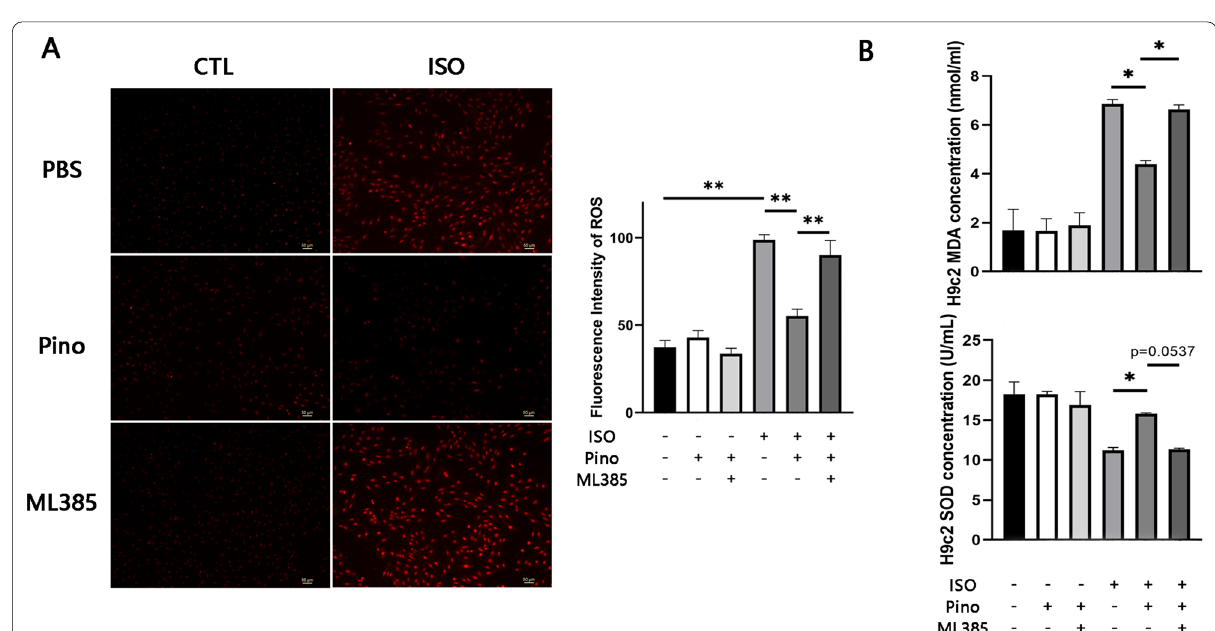
Fig. 5 In vitro incubation of Nrf2 inhibitor 5 μM ML385 counteract the antioxidant effects of pinocembrin. A , B ROS scavenging and antioxidant defense of pinocembrin were significantly offset by the application of ML385. *p < 0.05; **p < 0.01. ROS reactive oxygen species, Nrf2 nuclear factor erythroid 2-related factor